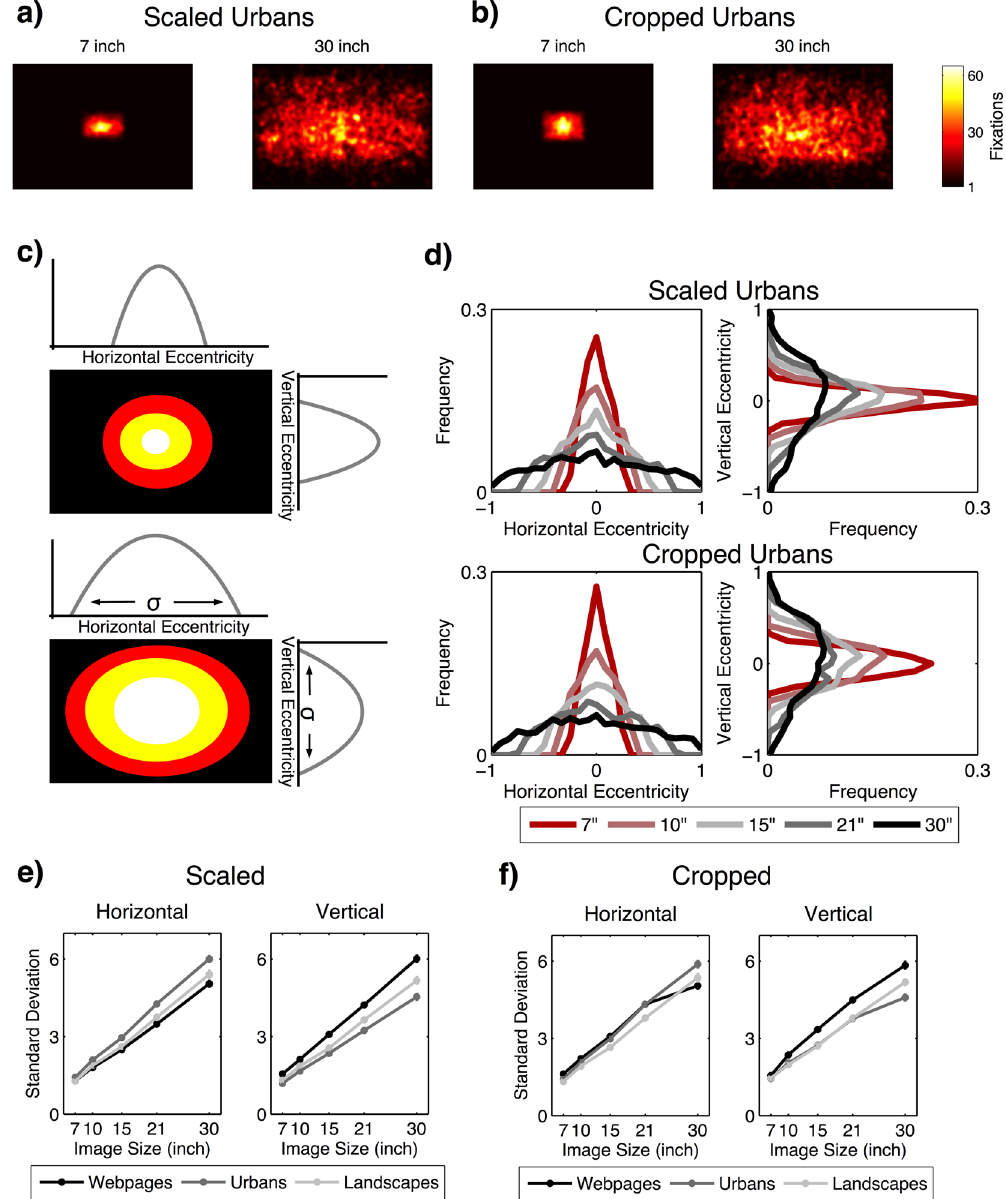
Figure 3. The distribution of fixations in terms of a fixation density map in the two-dimensional image space for ( a ) urban image in the scaled condition and ( b ) cropped condition. ( c ) Sketch showing the eccentricities of the fixation distribution in horizontal and vertical directions. The extent of the eccentricity was measured by the standard deviation. ( d ) Eccentricities of urban images in the scaled and cropped condition in horizontal and vertical directions for all image sizes. Plots for scaled ( e ) and cropped ( f ) images indicate the extent of the eccentricities measured by the standard deviation depending on image category and image size. Error bars indicate the standard error of the